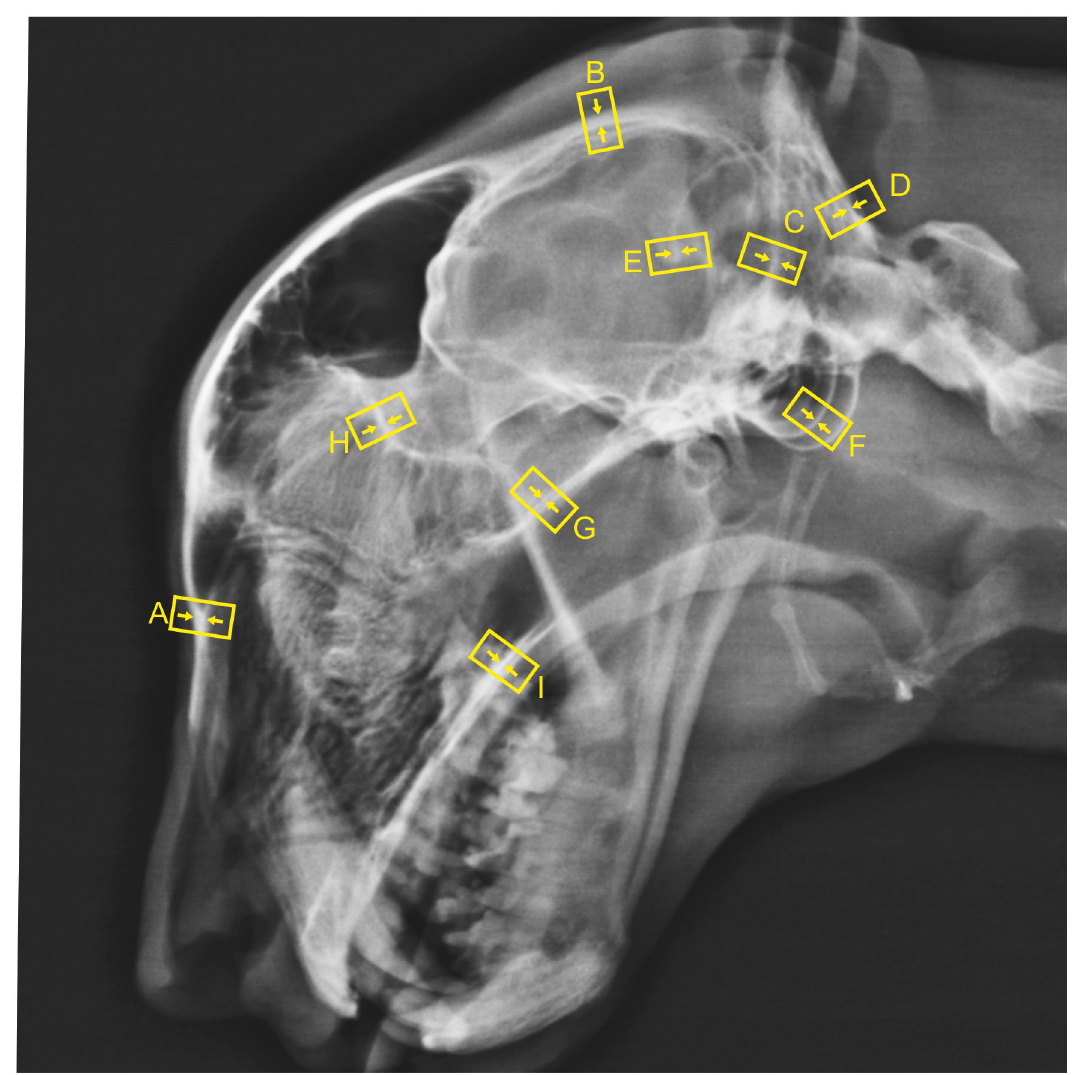
Fig 2. Latero-lateral radiograph of a four-year-old clinically sound captive cheetah displaying the measuring points of bone thickness: A: Nasal bone; B: Parietal bone; C: Nuchal crest; D occipital bone; E: Osseous tentorium; F: Tympanic bulla; G: Presphenoid bone; H: Cribriform plate; I: Palatine